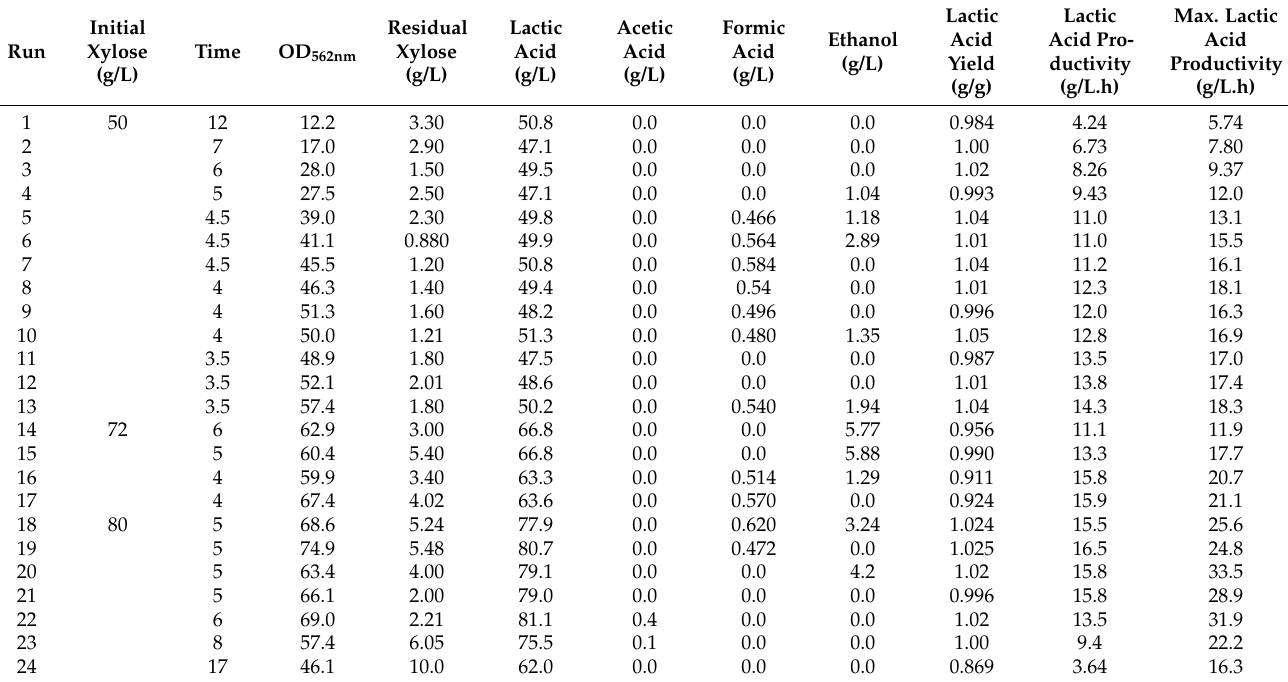
Table 1. Kinetic parameters for repeated-batch fermentation for lactic acid production from xylose by E. faecium s6 at controlled pH 6.5 and 45 ◦